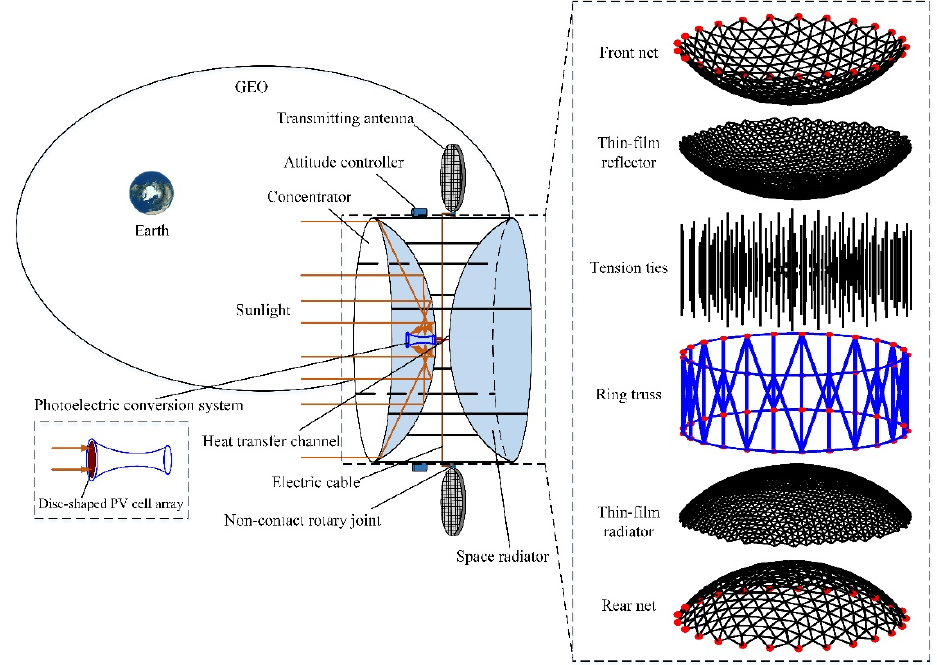
Figure 1. Diagram of the ring truss-based space solar power station.